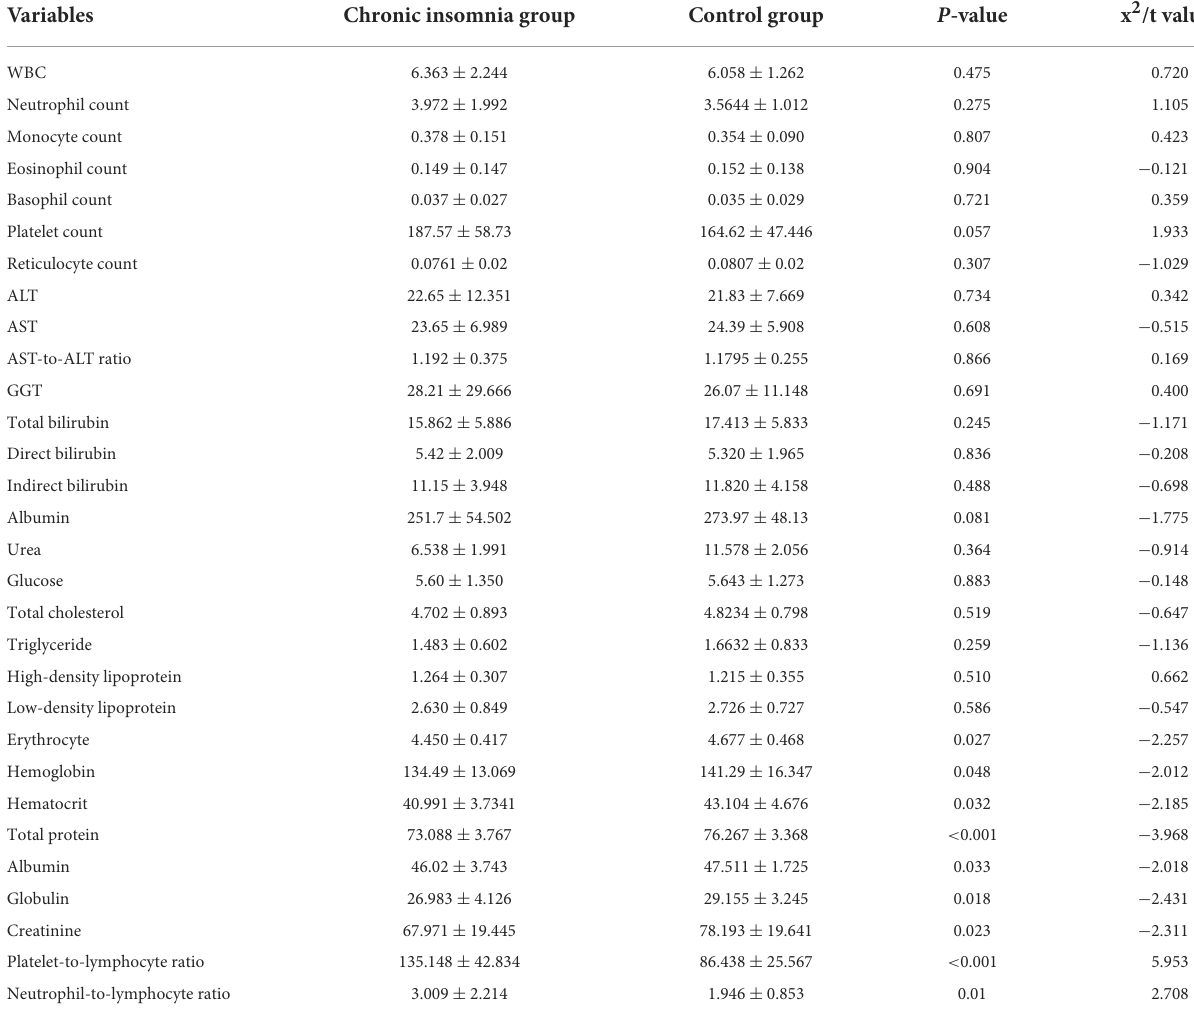
TABLE 2 Comparison of CBC and biochemical indices between the two